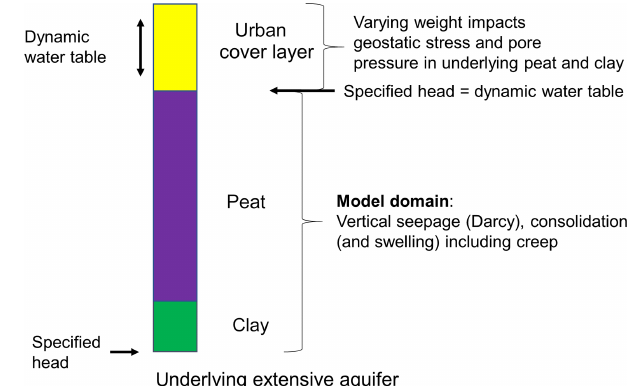
Figure 1. Conceptual model.